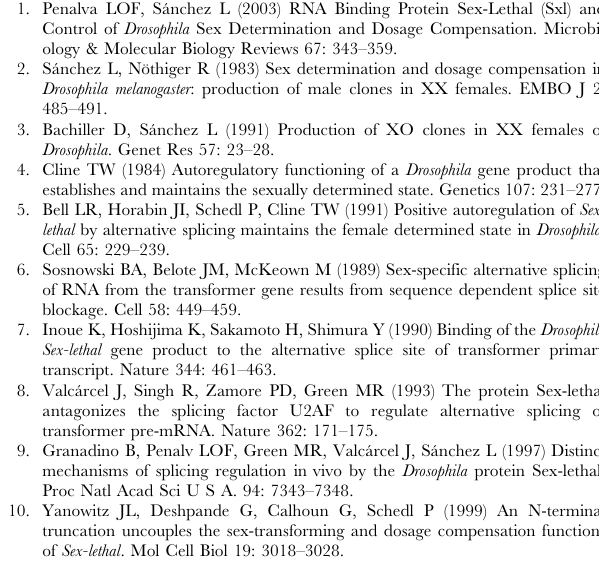
Figure S1 Examples of binding of SXL proteins to one single SXL-binding site. The amount of SXL proteins and RNA substrate is indicated in m g above each lane. Figure S2 EMSA (A) and Western-blot (B) for the interaction between the Sciara SXL (SXS) protein and the Drosophila SXL- binding site. (A) The RNA sequence is described in Materials and